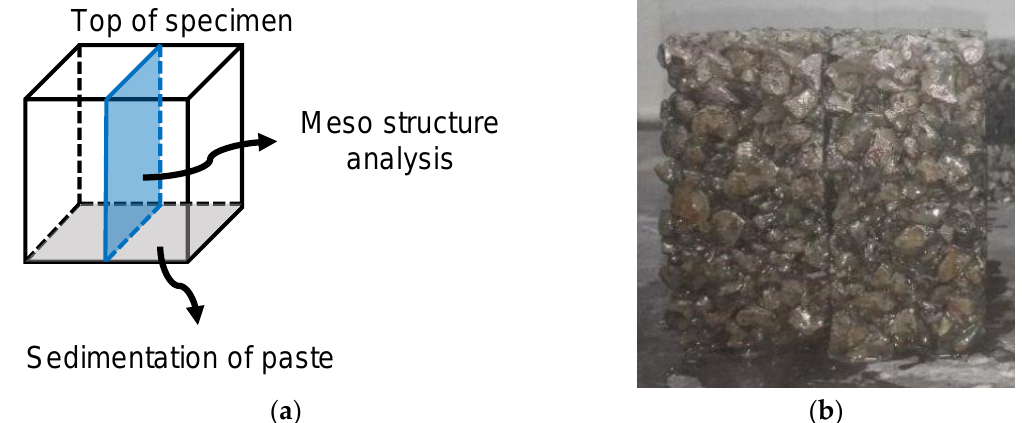
Figure 6. ( a ) The diagram of surfaces for sedimentation of paste and mesostructure analysis, and ( b ) the real specimen after cutting.